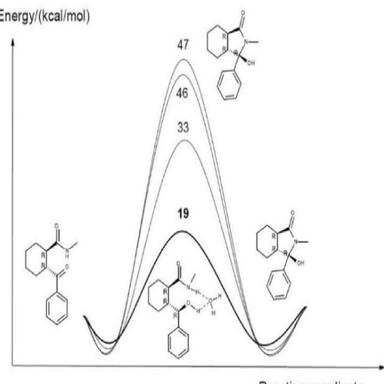
DFT computed activation barriers for uncatalyzed (top), acid catalysed (2nd from top), solvent assisted (3rd from top), or acid catalysed and solvent assisted (bottom) reactions.